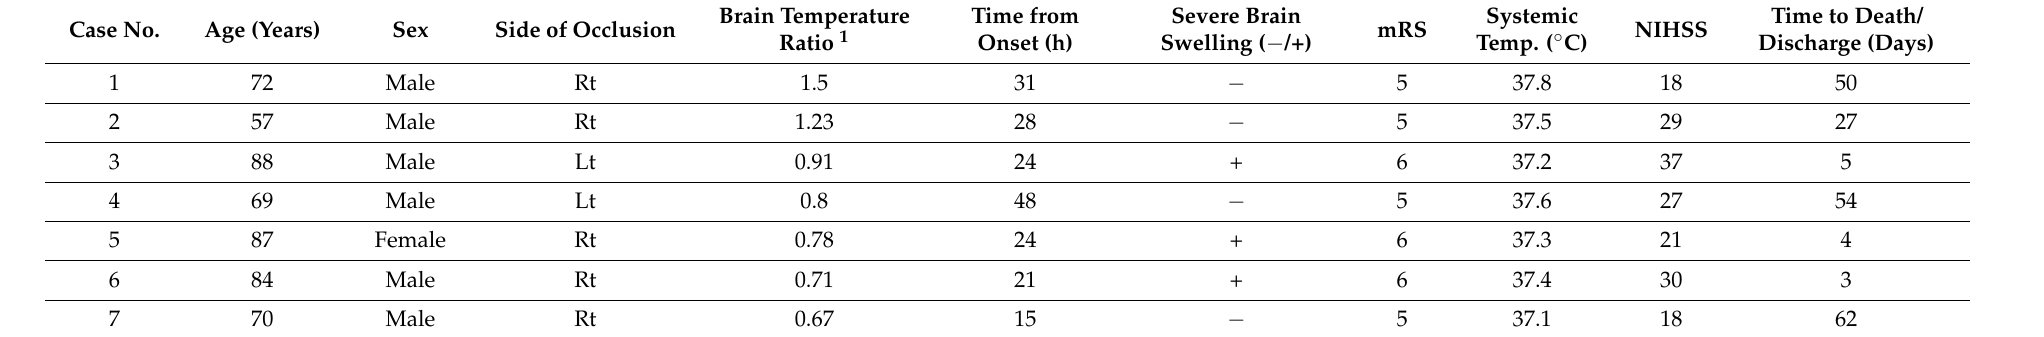
Table 1. Summary of clinical findings in seven patients with internal carotid artery